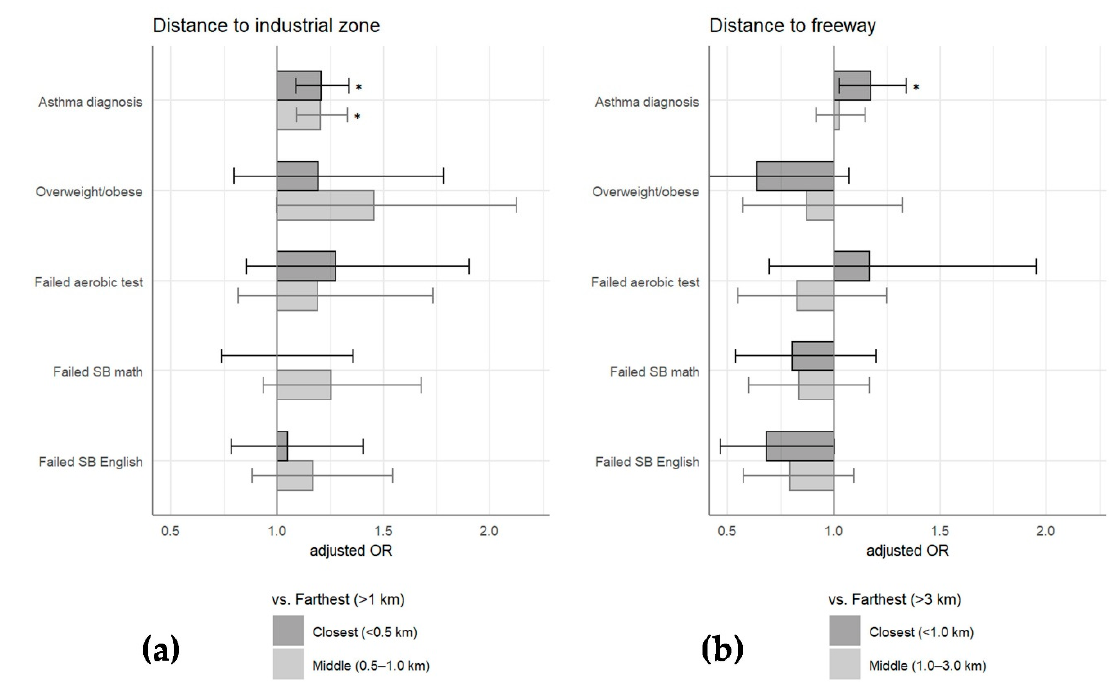
Figure 2. Regression models for asthma and academic outcomes by distance to industrial zone and freeways. Adjusted odds ratios with 95% CI shown among closest distance group vs. farthest distance group (darker grey) and middle distance group vs. farthest distance group (lighter grey) for ( a ) industrial zones and ( b ) freeways. * with p < 0.05.